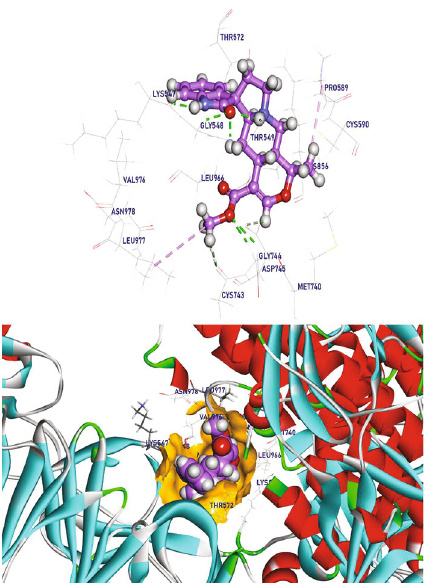
Figure 10: Mitraphylline docked in RBD-SARS-CoV-2 Omicron spike protein, hydrogen bonds (green), and the pi interactions are represented in purple